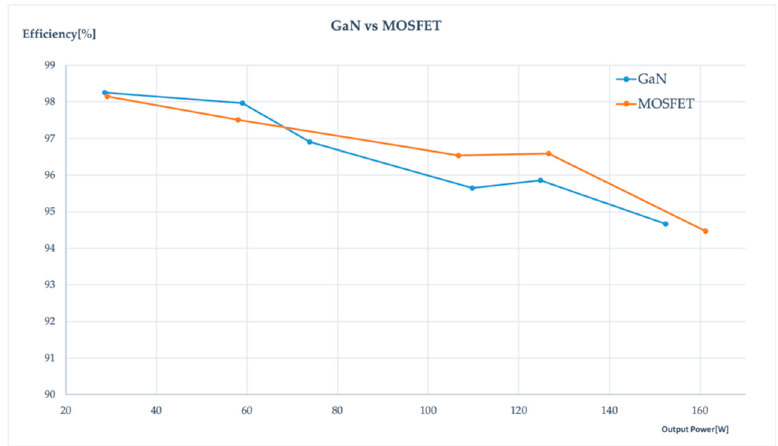
Figure 17. Evolution of the efficiency with the output power for the same topology but implemented